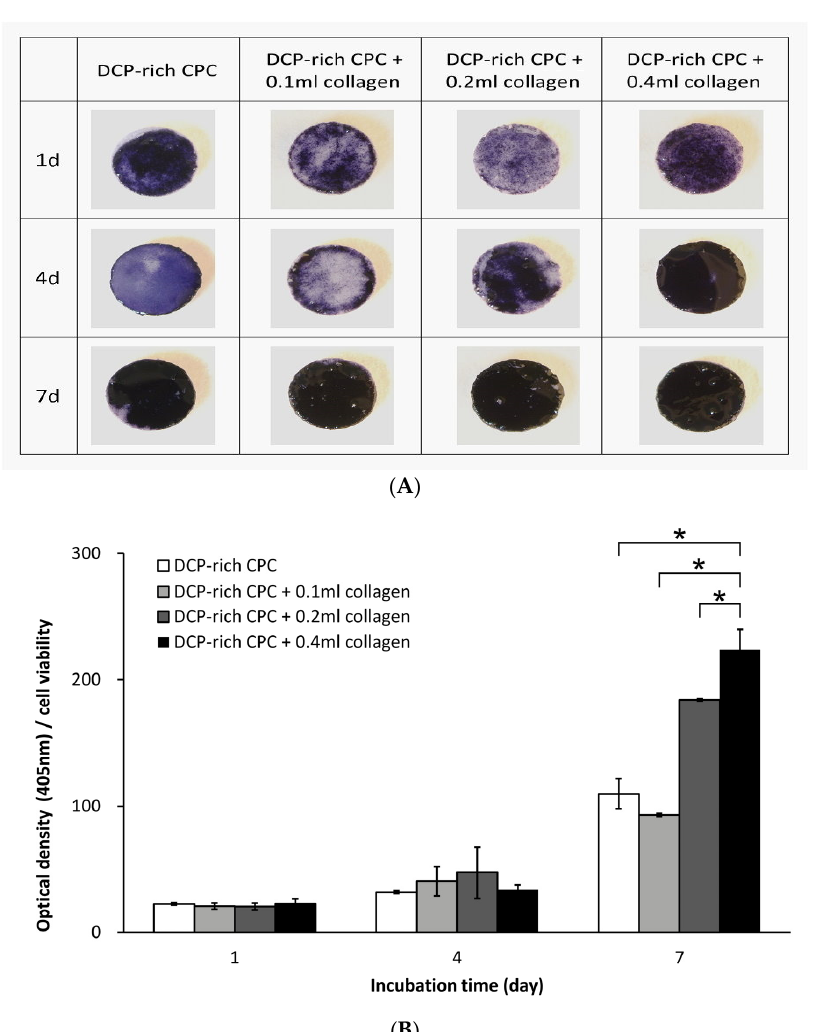
Figure 3. ( A ) ALP staining of D1 cells seeded on different DCP-rich CPC samples after days 1, 4, and 7 of incubation; ( B ) OD and ALP activity of each D1 cell seeded on different CPC samples after days 1, 4, and 7 of incubation ( n = 5). * p < 0.05.